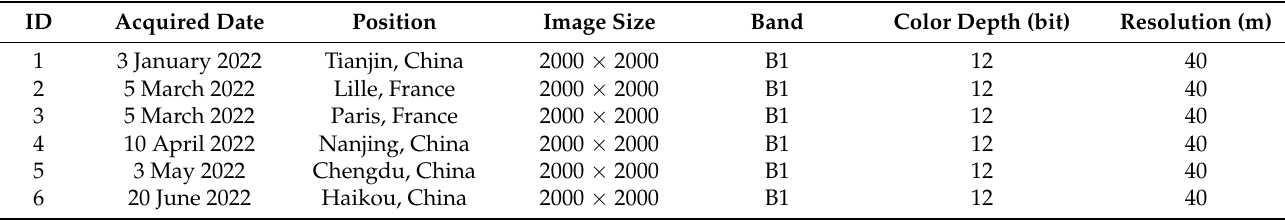
Figure 9. Six test images. ( a – f ) All test images have been processed by logarithmic stretching for better visualization. Table 2. The detailed information of six test images.